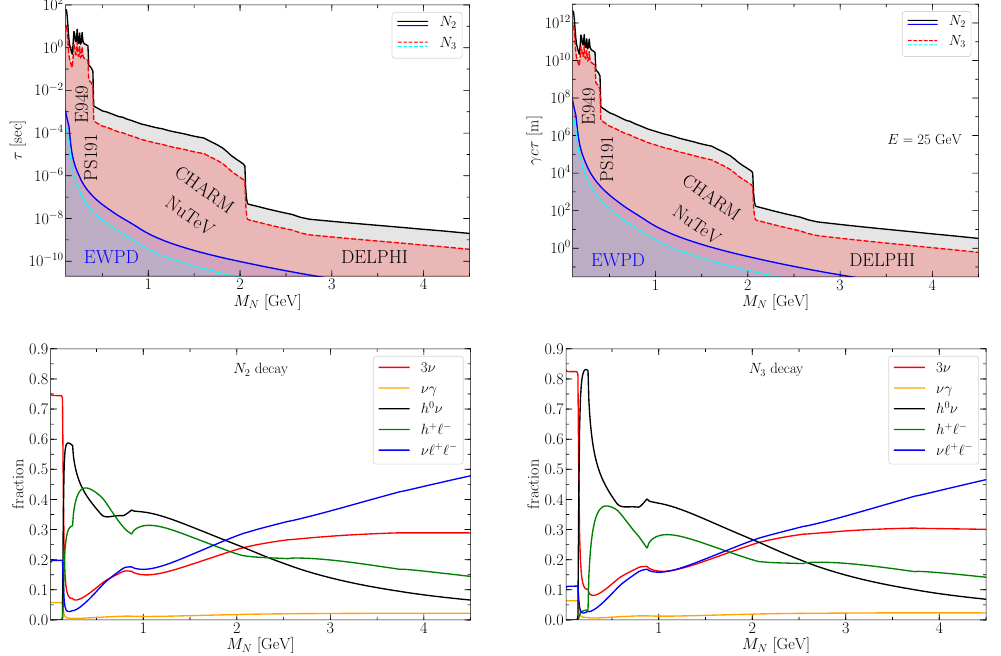
Figure 4 . Top: minimum lifetime (left) and decay length (right) of the HNLs N and N , for the 2 3 case of normal mass hierarchy. Upper curves are for mass M , lower curves for M , N < m s N > m s which determines whether weak decays or N (cid:23) s dominates. Decay length assumes energy ! E = 25 GeV, appropriate for SHiP experiment. The shaded regions are excluded. (The wiggles in the mass range 0 : 2 < M 0 : 4 GeV come from the E949 bound [47] present in (cid:12)gure 4.11 N <